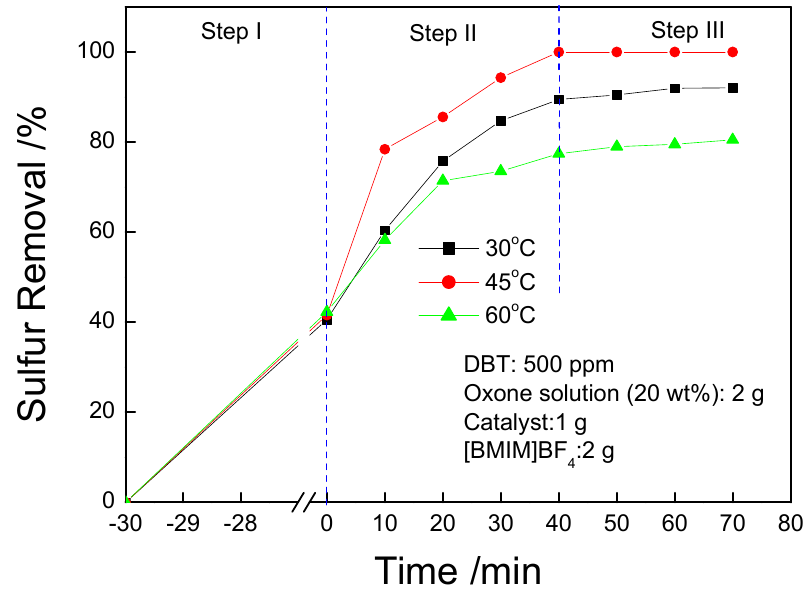
Figure 8. Effect of temperature.